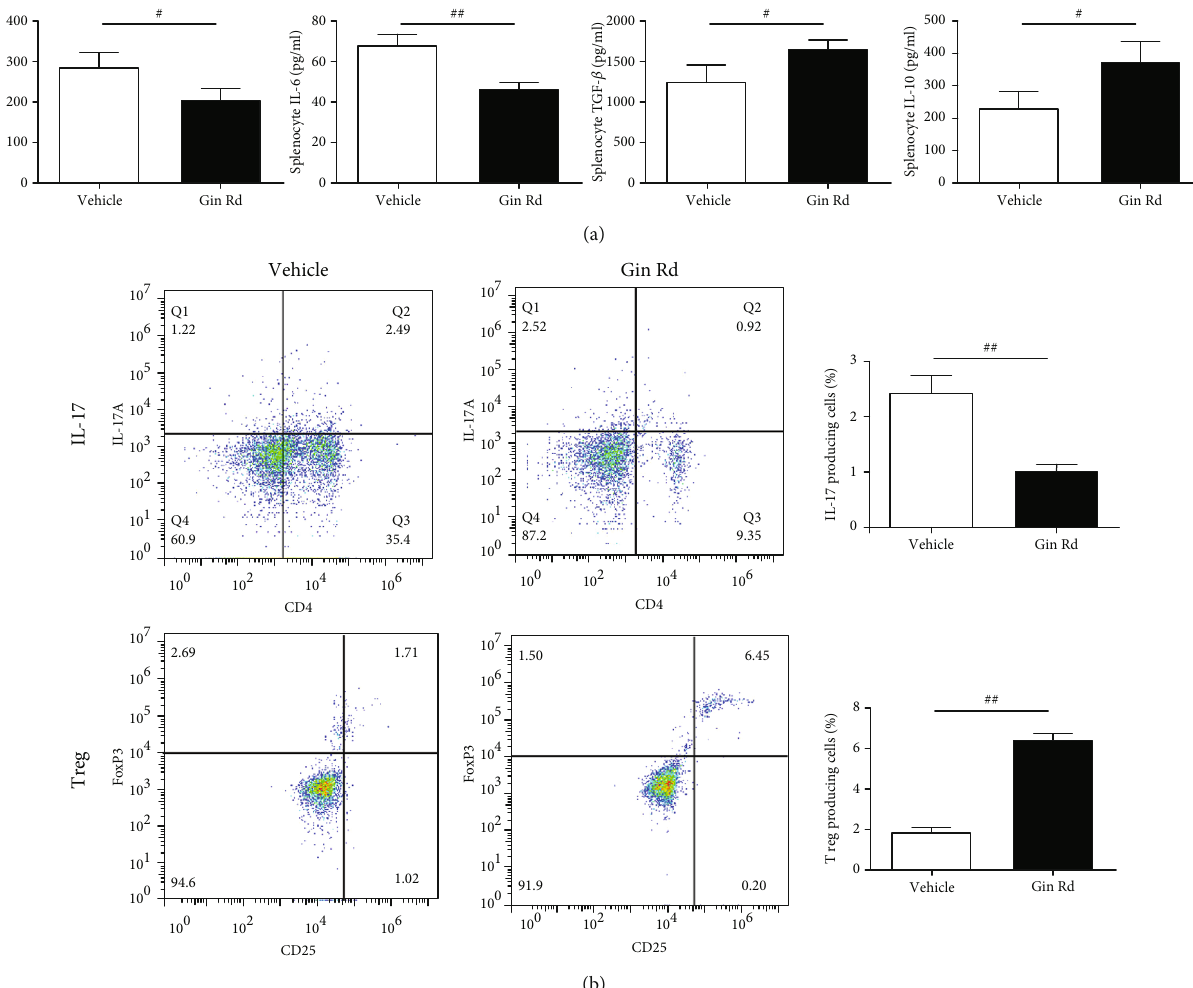
Figure 7: The e ff ect of Ginsenoside Rd on in fl ammatory cytokine levels and Treg/Th17 cell percentages in splenocytes of EAE. Splenocytes were isolated from EAE mice and further treated with 10 μ g/ml of MOG for 48h, with or without Ginsenoside Rd (50 μ M). (a) ELISA 33-35 assay for detection of the levels of IL-6, IL-10, IL-17, and TGF- β in splenocyte supernatants ( n = 3 ). (b) Flow cytometry assay for detection the percentages of CD4+ IL-17+ Th17 and CD4+ Foxp3+ Treg cells in splenocytes ( n = 3 ). Data are expressed as the mean ± SEM of each group ( n = 3 ). # P < 0 : 05 , ## P < 0 : 01 vs. vehicle group. Gin Rd: Ginsenoside